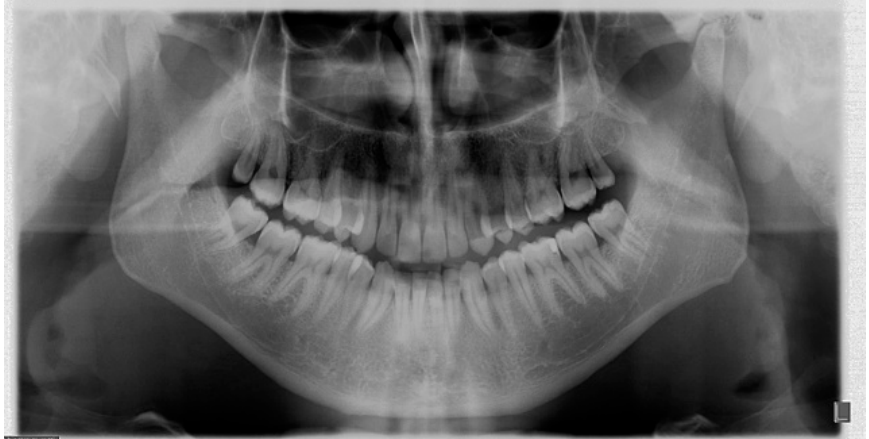
Figure 5. Nodding down. Panoramic radiography. The upper concavity of the occlusal plane is pronounced.